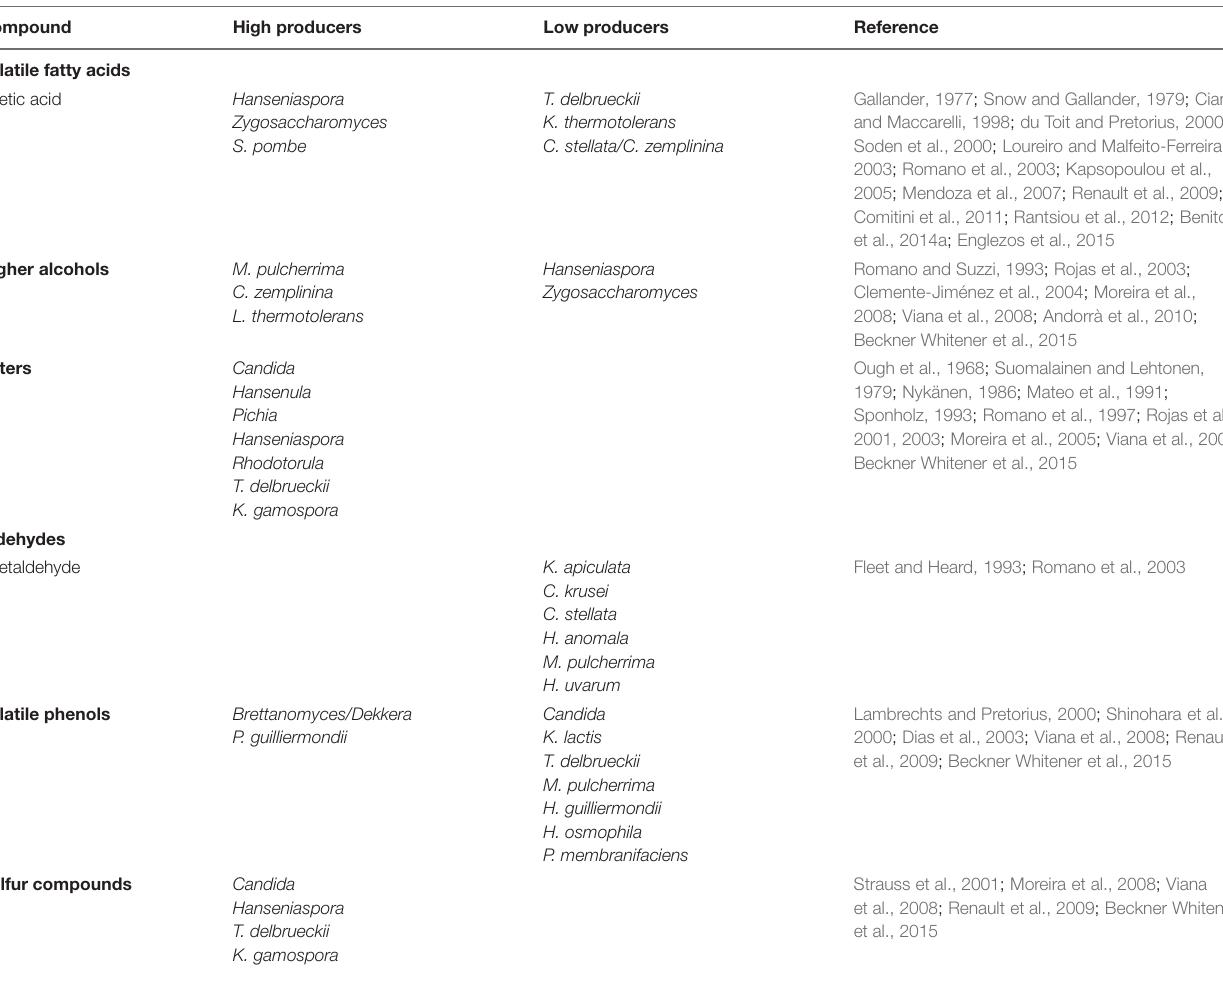
TABLE 2 | Secondary aroma compounds produced by non- Saccharomyces wine